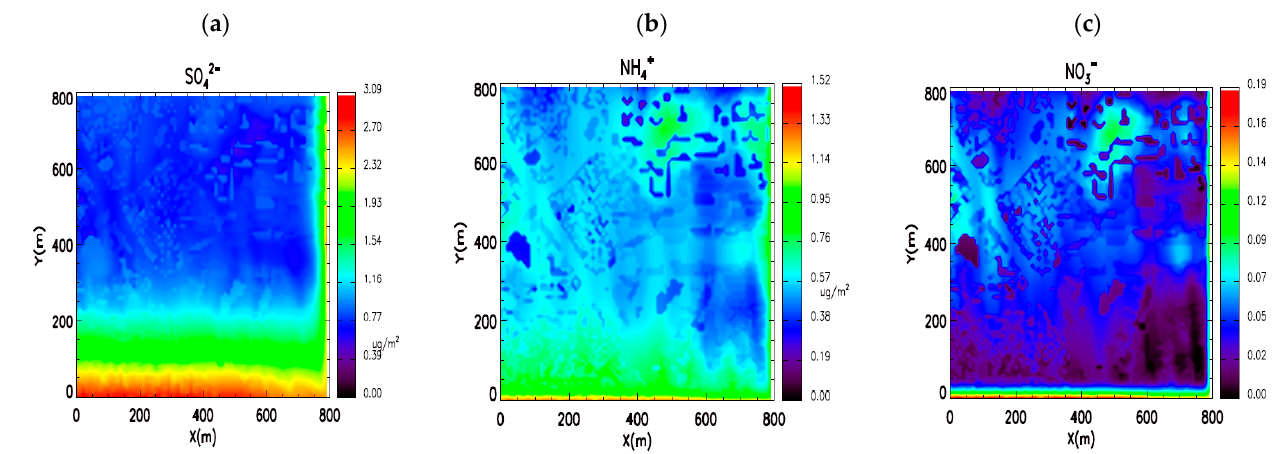
Figure 9. Wet deposition flux of ( a ) sulfate, ( b ) ammonium, and ( c ) nitrate due to washout processes. Units are µ g m − 2 .